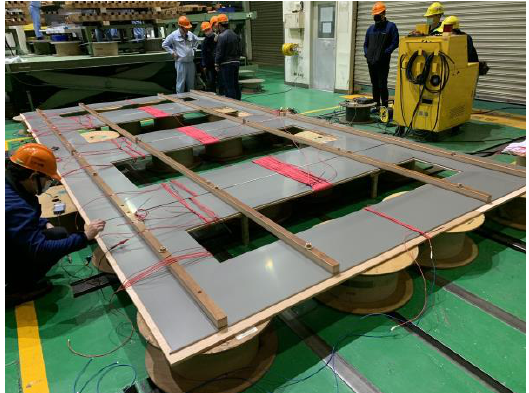
Figure 16. The measured three-phase five-limb transformer diagram.